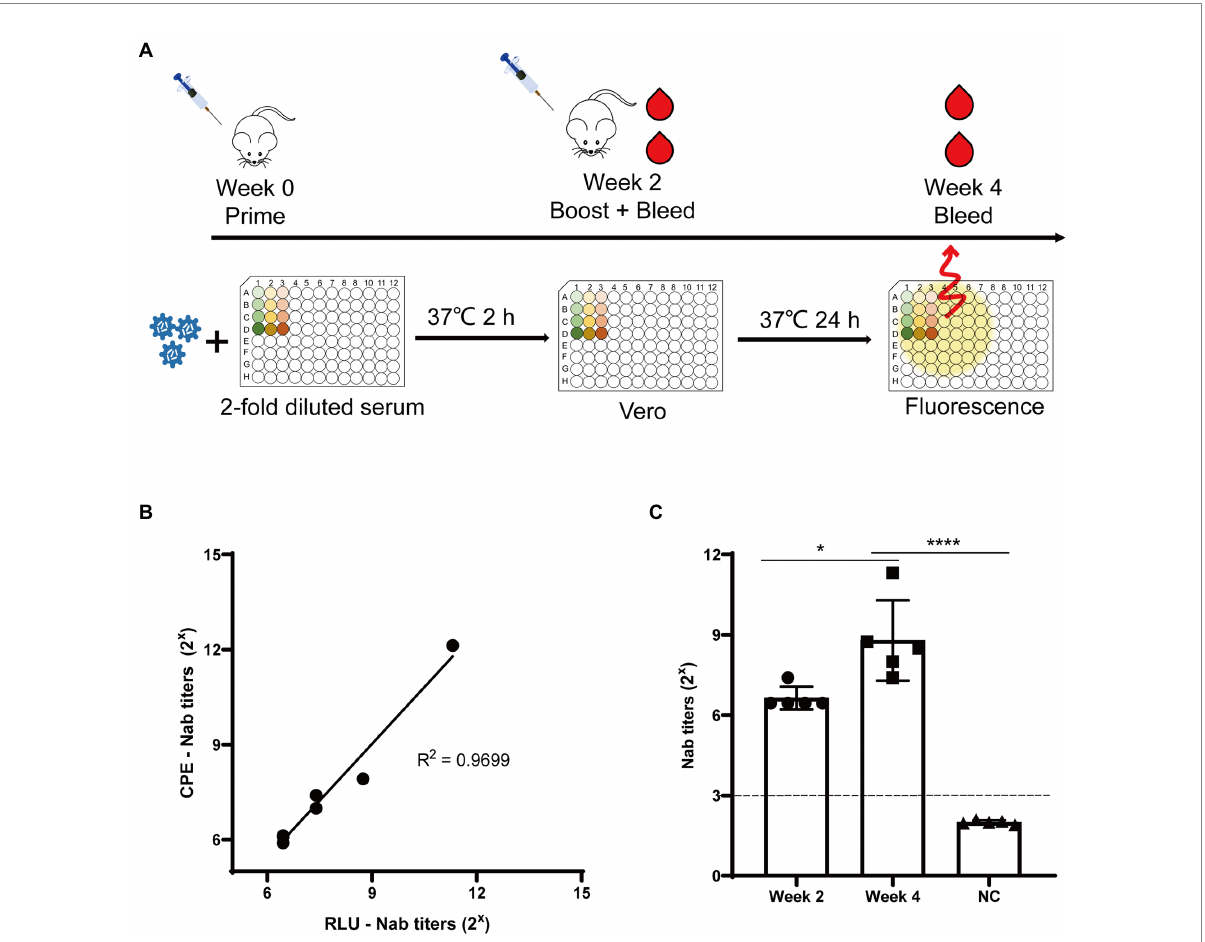
FIGURE 6 Luminescence-based tests for CA16 neutralizing antibodies. (A) Schematic diagram of the immunization procedure and analysis of neutralization antibodies in mice. (B) Correlation between the traditional neutralizing antibody test (CPE-Nab) and the luciferase-based neutralizing antibody test (RLU-Nab). (C) Serum neutralizing antibody titers at second and fourth week post primary immunization. Statistical differences were determined using t-test (* P < 0.05; ** P < 0.01; *** P < 0.001; **** P <